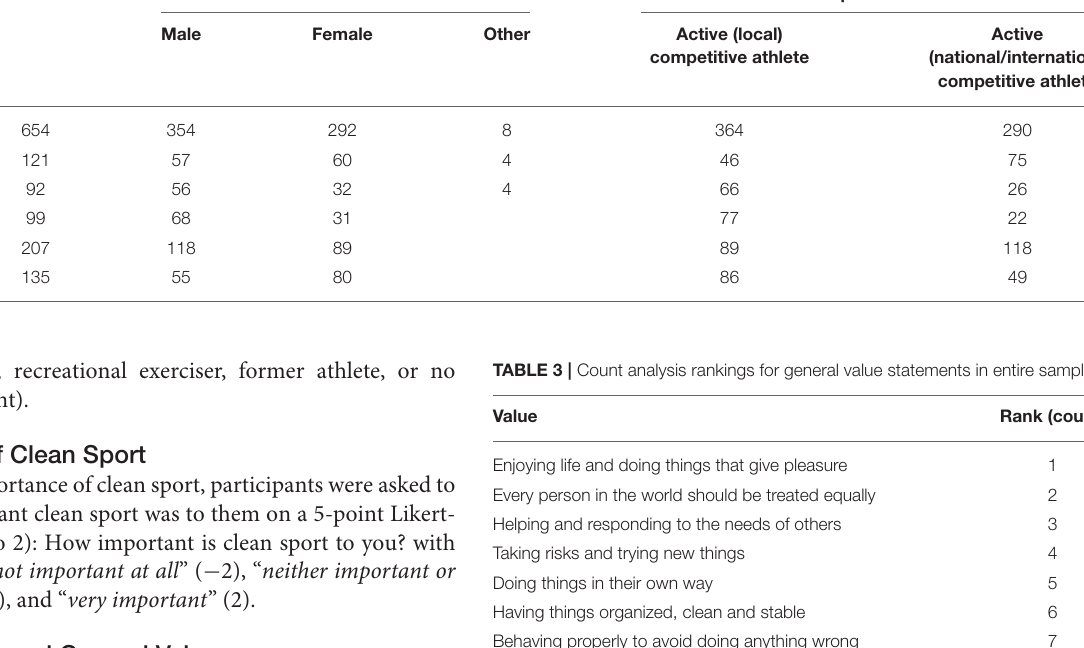
TABLE 2 | Breakdown of final sample. Country